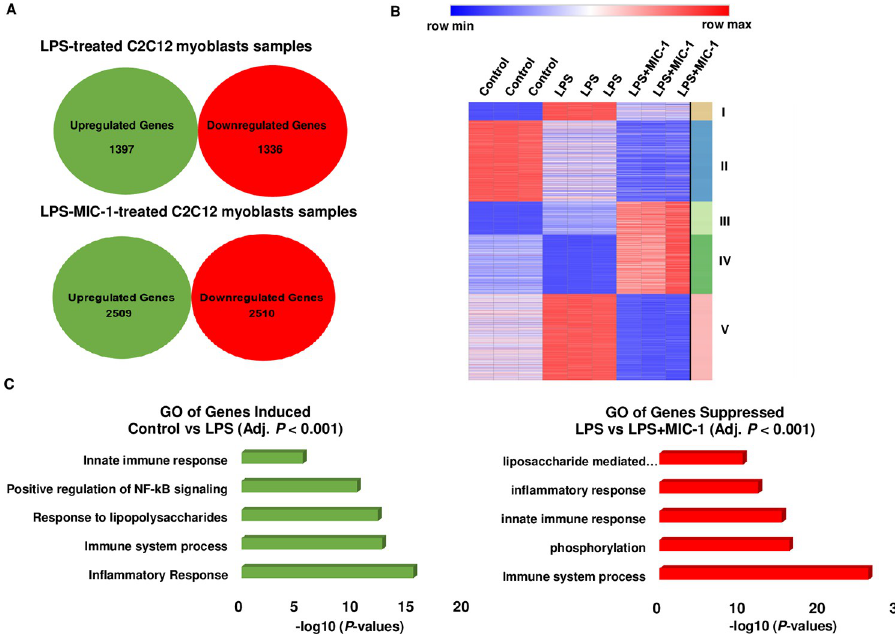
Fig 2. Transcriptome analysis of moringa isothiocyanate-1 (MIC-1) in C2C12 myoblasts. (A) Venn diagrams depict genes significantly (absolute log2-fold change > 1; Adj. P < 0.001) upregulated/downregulated due to LPS (control vs. lipopolysaccharide (LPS)-treated samples) or MIC-1 (LPS-treated samples vs. LPS-MIC-1-treated samples) in C2C12 murine muscle cells. (B) Heat map of differentially expressed genes in five k-means clusters. Column, row, and color represent a sample, gene, and expression level, respectively. (C) Gene ontology (GO) analysis of upregulated genes due to LPS (control vs. LPS-treated samples) and downregulated genes due to MIC-1 (LPS-treated samples vs. LPS-MIC-1-treated samples), represented as negative log10 ( P